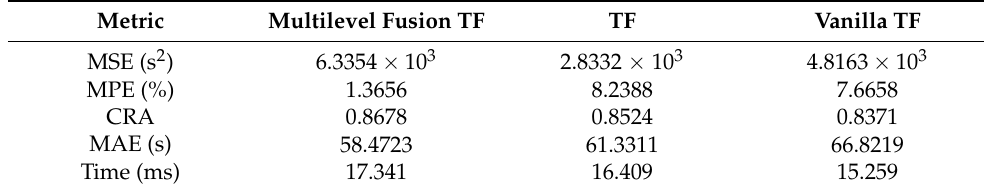
Table 7. Performance of the RUL prediction for the next 48